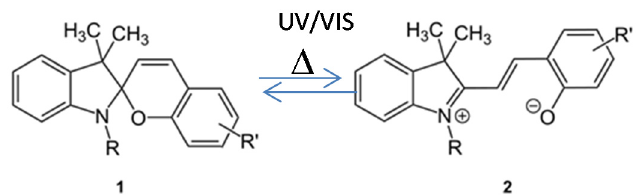
Figure 2. Structural changes of spiropyran during photochromism. Reprinted with permission from Kinashi et al.